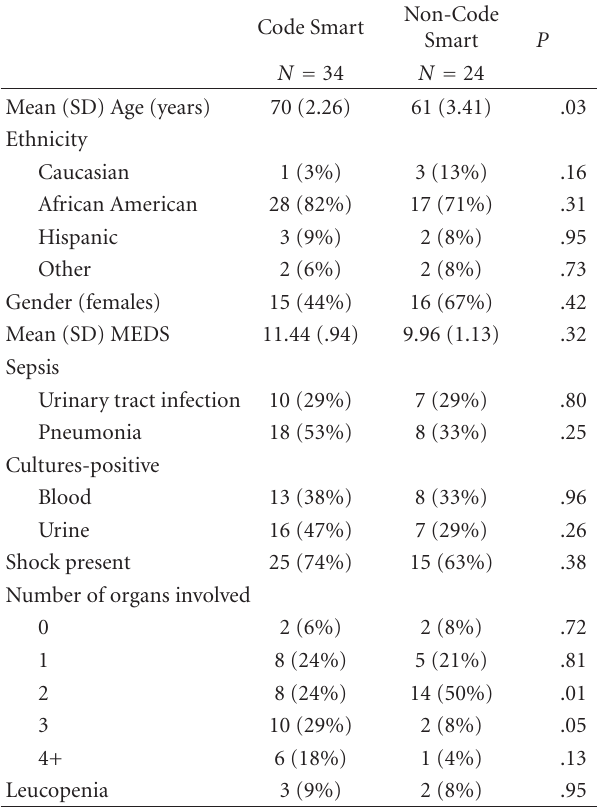
Table 1: Patient characteristics between Code SMART and Non- Code SMART Groups.